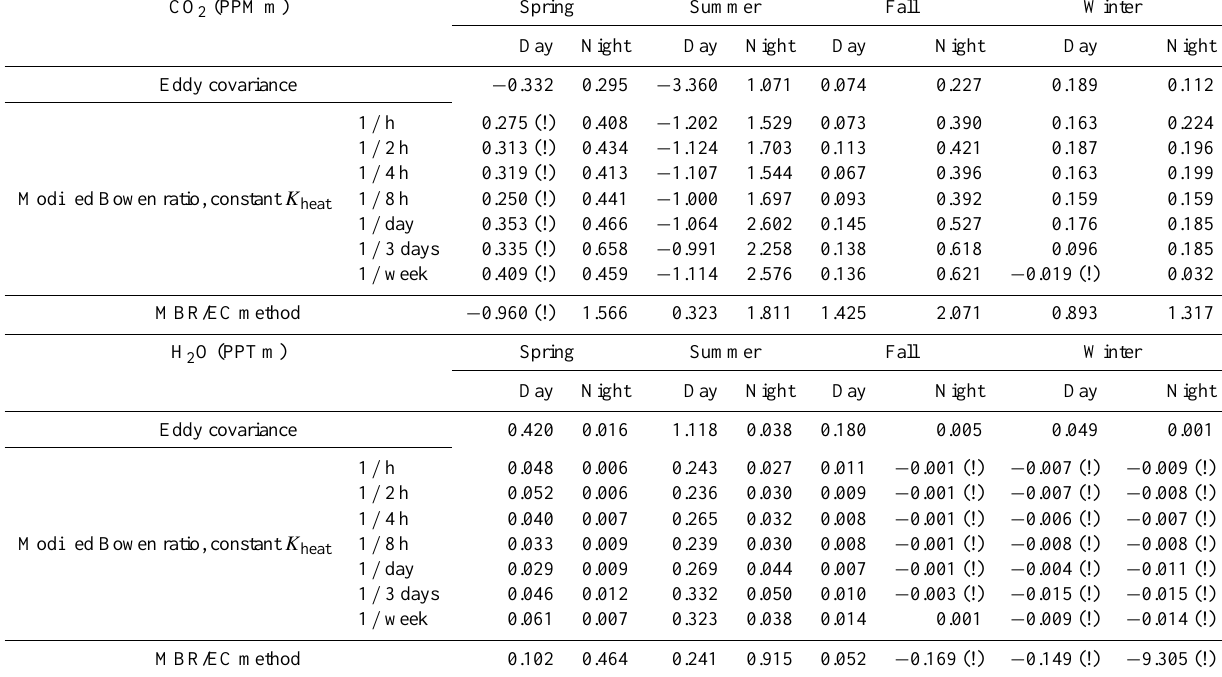
Table 1. Cumulative fluxes for 8h periods representing day and night across the 2 month periods representing spring, summer, fall and winter. Fluxes measured by the MBR method that are in the opposite direction to those measured by the EC method are marked with “(!)”. Positive fluxes are defined as fluxes moving upwards from the canopy. The ratio of MBR results over EC results is based on the geometric mean of the MBR results divided by the EC result. The MBR fluxes for the 1 week sampling period were left out in the calculation of the geometric mean during the day in winter for CO 2 and during the night in fall for H 2 O. This table shows fluxes calculated with a fixed value for K heat